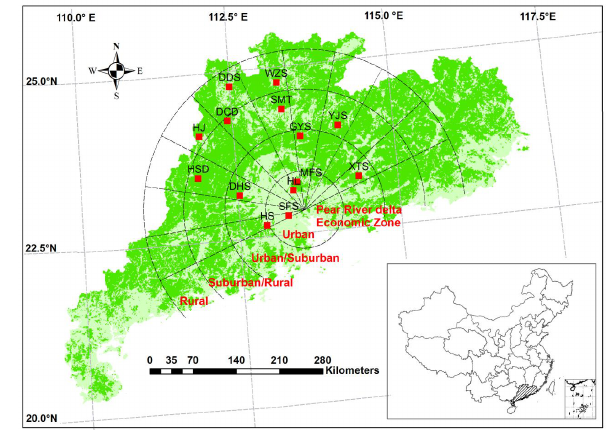
Fig. 1. Location of our study sites in Guangdong Province of south- Fig 1. Location of our study sites in Guangdong province of southern China. A total of fourteen 477 ern China. A total of fourteen Masson pine forests were selected Masson Pine forests were selected along the transect. The detailed information for each forest is 478 along the transect. The detailed information for each forest is listed in Table